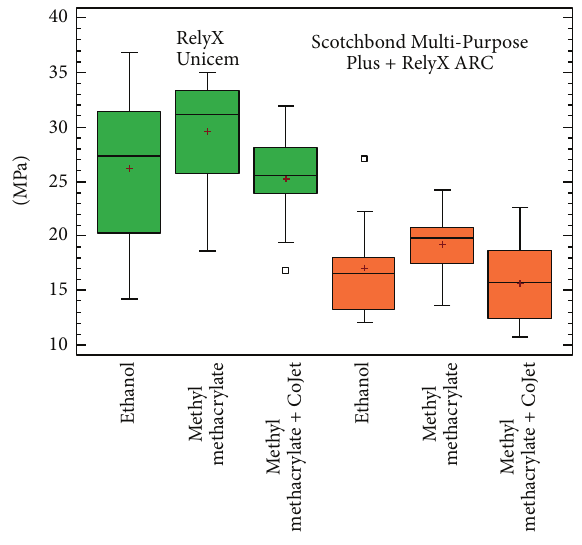
Figure 3: Box and whisker plots for each sample.